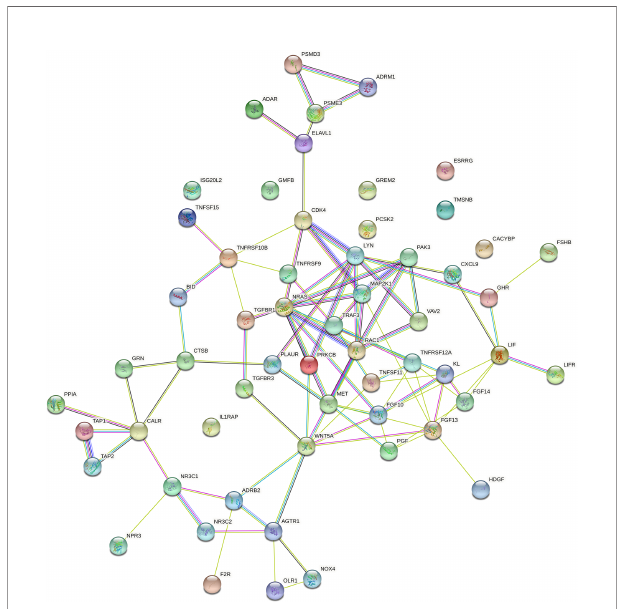
FIGURE 5 | The PPI network of immune-related mRNAs in the regulatory ceRNA network in GC.